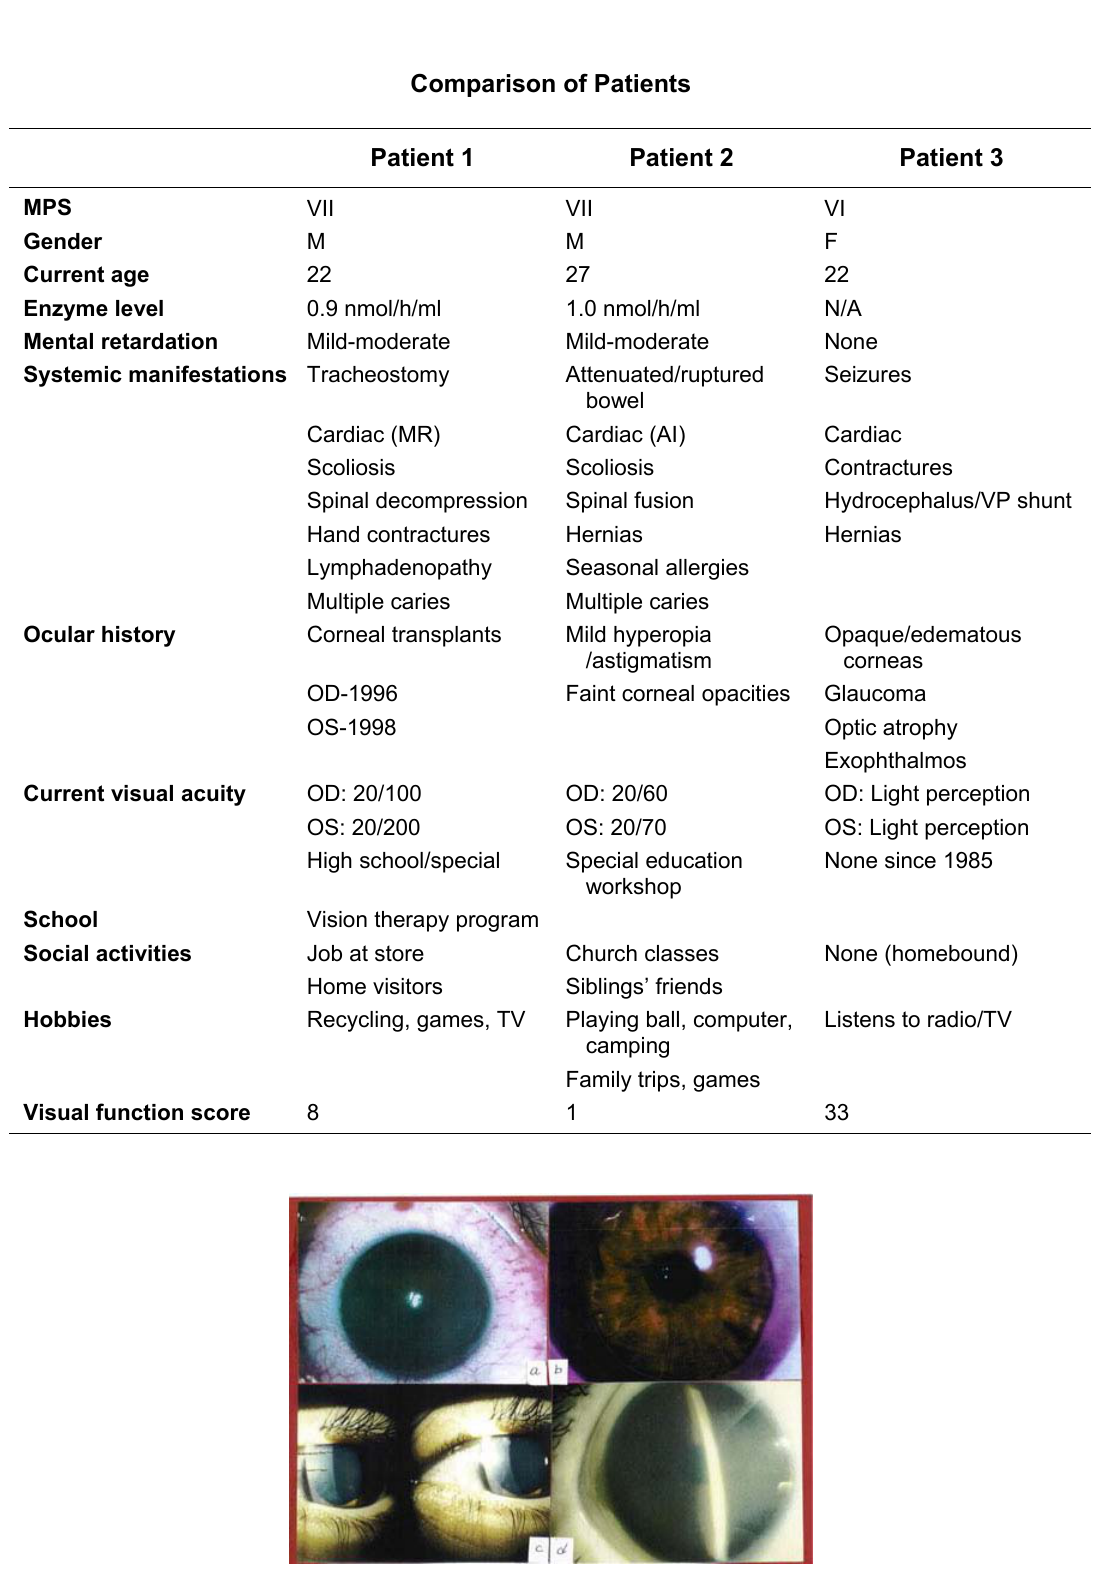
FIGURE 1. Comparison of corneal opacities: (a) patient 1 prior to surgery with opaque, thick cornea; (b) patient 1 with clear graft following corneal transplant; (c) patient 2 with mild, peripheral stromal opacities; (d) patient 3 with dense, thick, opaque